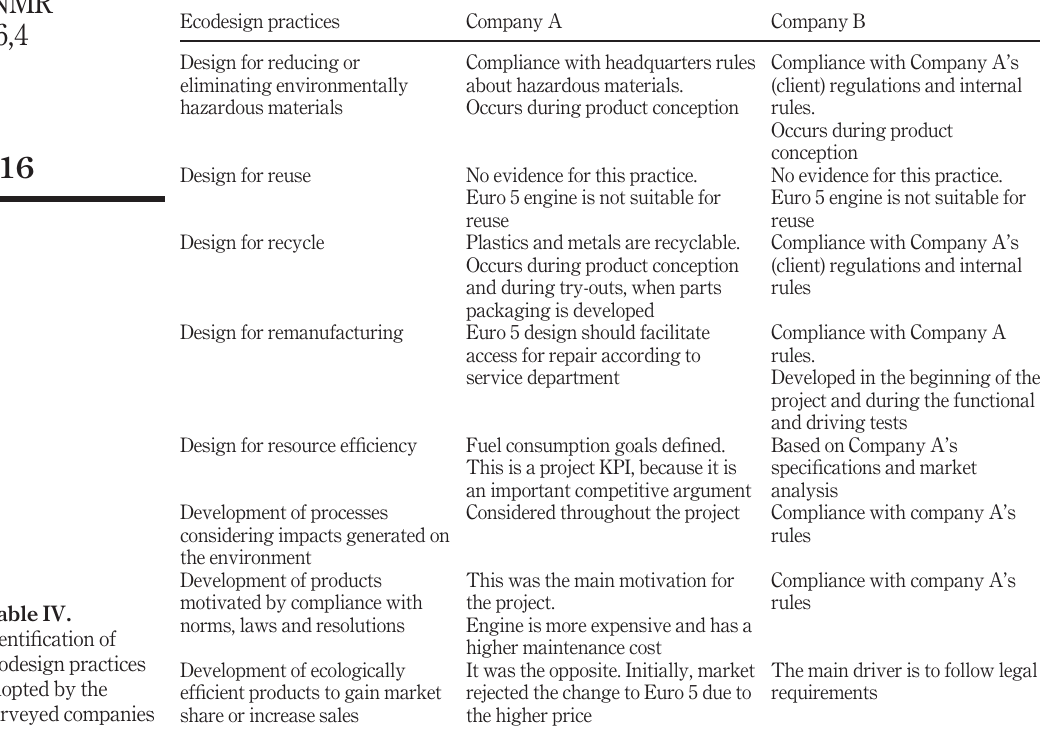
ecodesign practices adopted by the surveyed companies